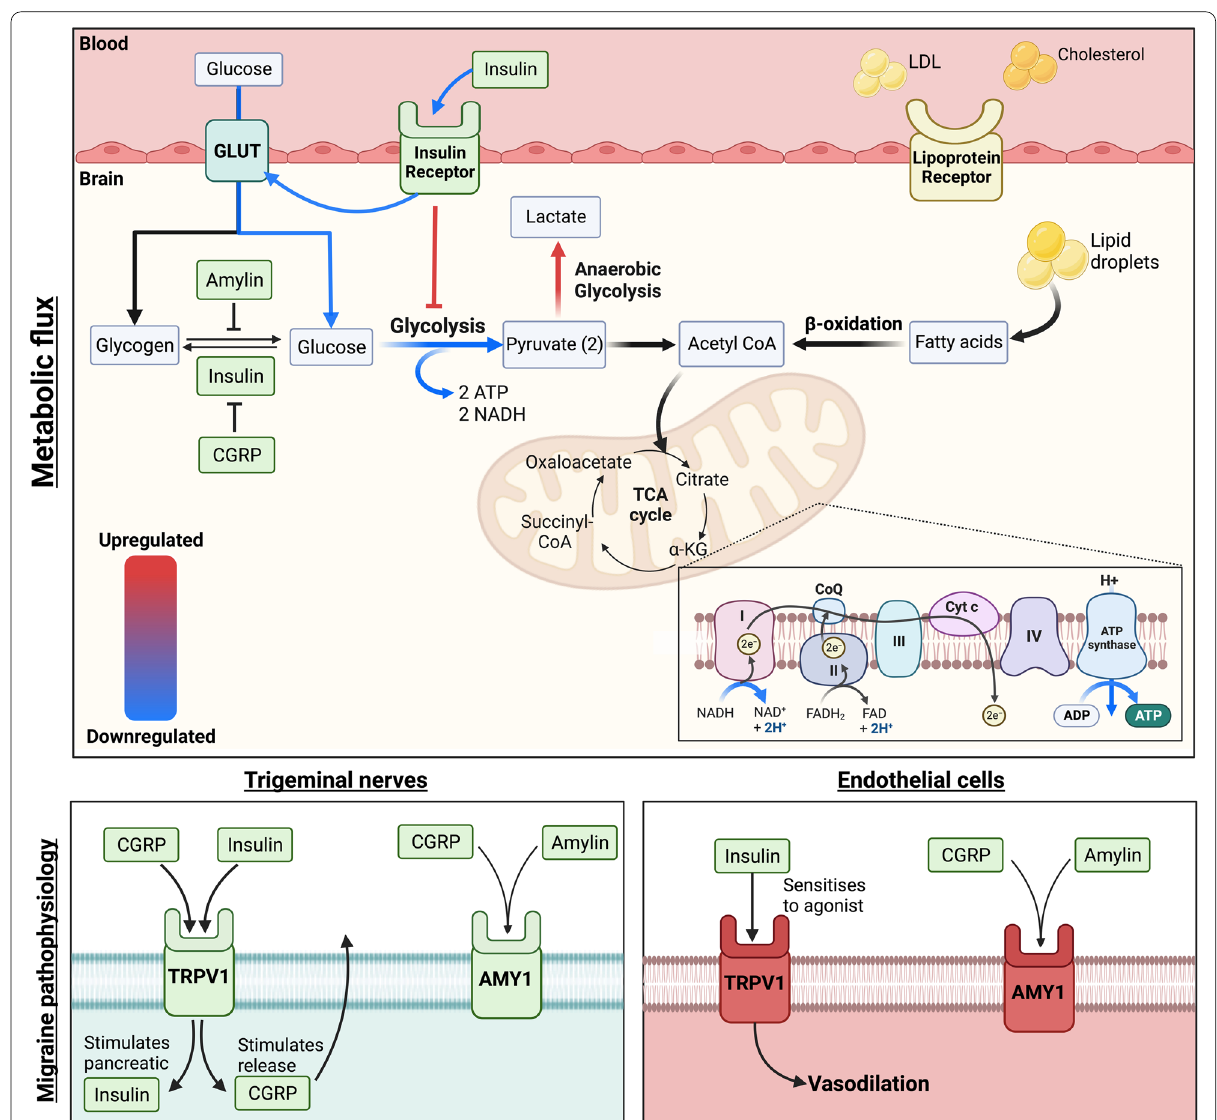
Fig. 1 Hypothesised alterations in metabolic flux which may contribute to migraine pathophysiology. The activity of numerous vital metabolic pathways is altered in migraine patients, which may lead to the upregulation of nociceptive peptides. Moreover, metabolic hormones including insulin and amylin act on receptors implicated in nociception in trigeminal nerves and vasodilation in endothelial cells, pathways which are both involved in migraine pathophysiology. α-KG; α-ketoglutarate, ADP; Adenosine di-phosphate, AMY1; Amylin type 1 receptor, ATP; Adenosine tri-phosphate, CGRP; Calcitonin gene related peptide, CoQ; CoenzymeQ10, Cyt c; Cytochrome C, FAD; Flavin adenine dinucleotide, GLUT; Glucose transporter, TCA; tricarboxylic acid